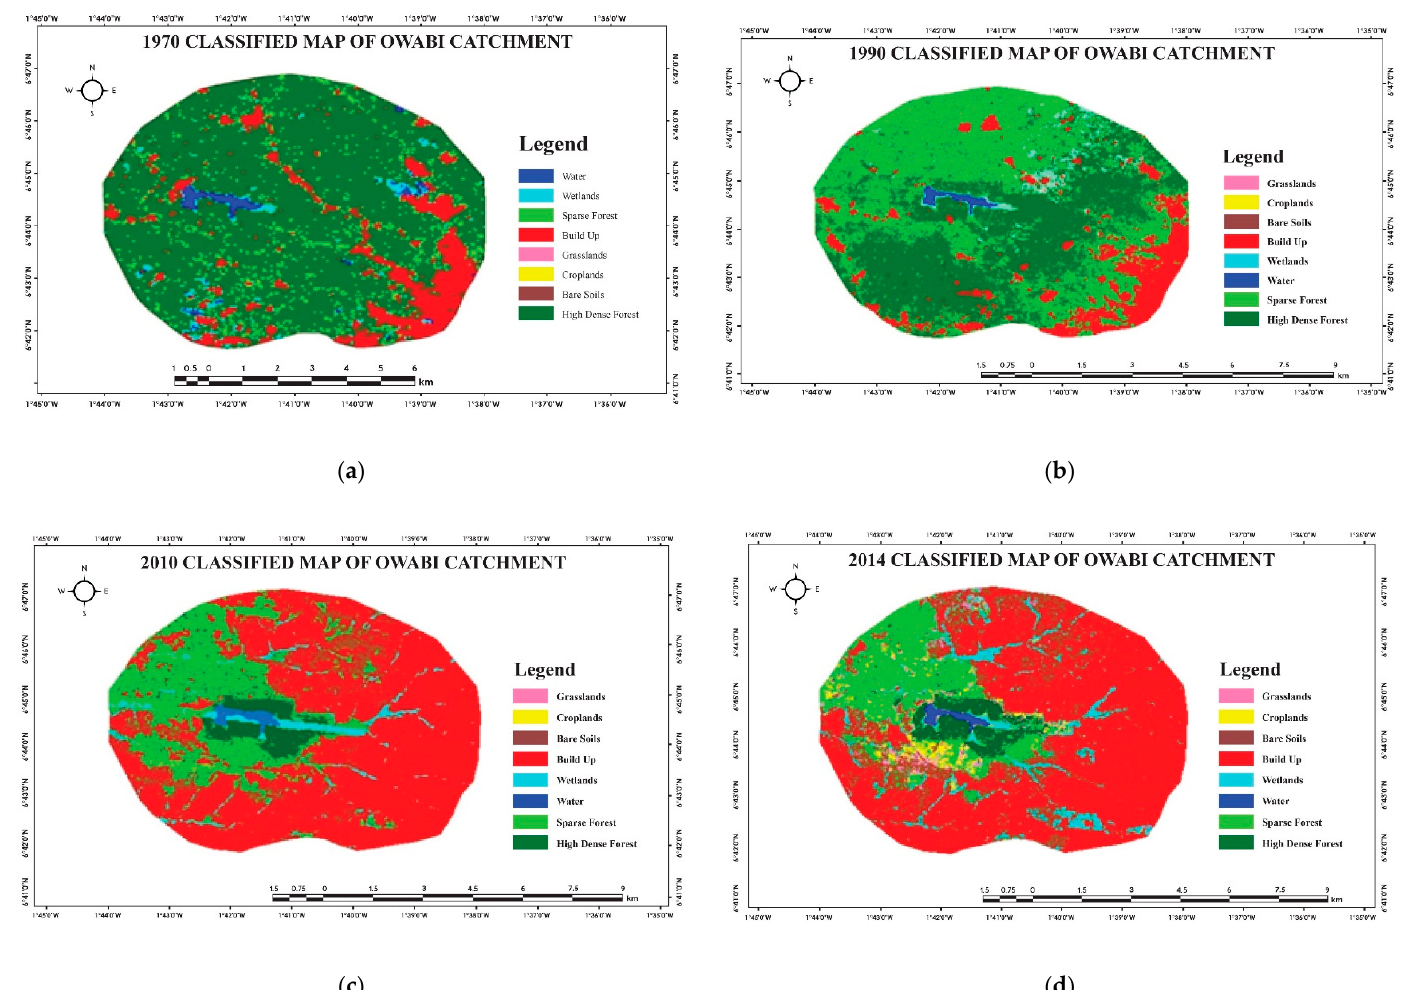
Figure 2. Classified maps of the Owabi catchment for 1970 ( a ), 1990 ( b ), 2010 ( c ) and 2014 ( d ).